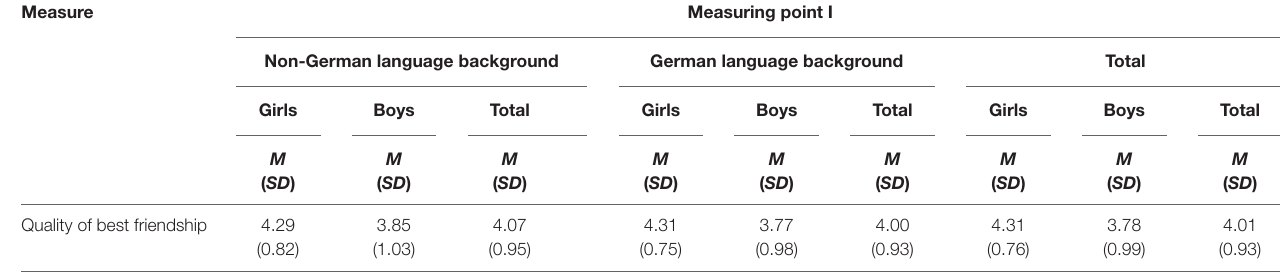
Quality of best friendship